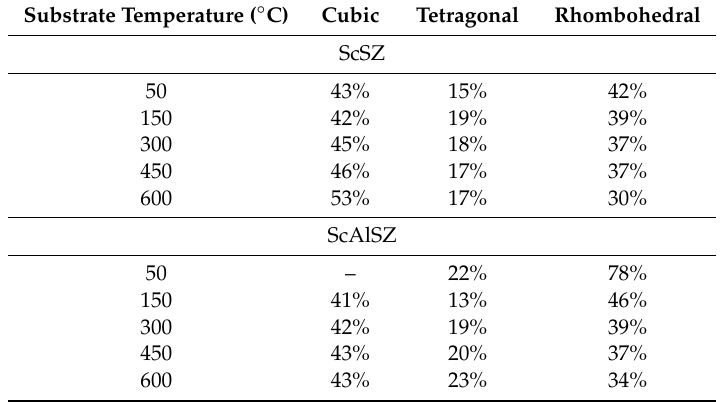
Table 2. The ratio of cubic, tetragonal, and rhombohedral phases in the ScSZ and ScSZAl thin films.